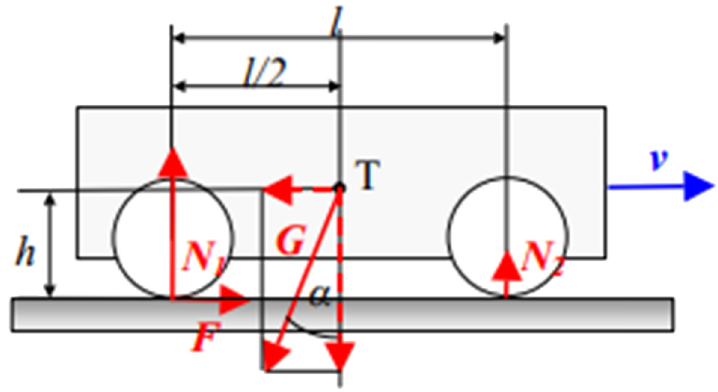
Figure 2: Automatic tractor